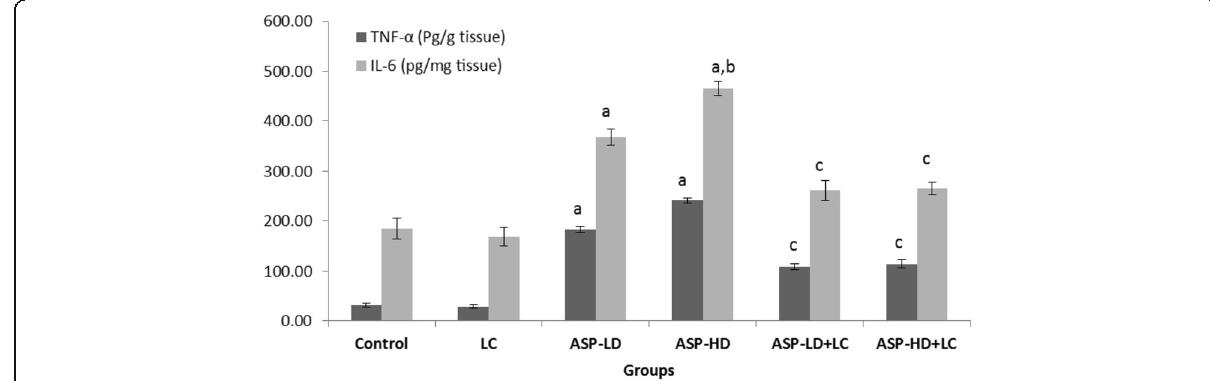
Fig. 1 Effect of L -carnitine on TNF- α and IL-6 in the brain of male rats treated with aspartame. Values are expressed as mean ± SE, n = 8. The significant value was represented at the top of the column. TNF- α , tumor necrosis factor – alpha; IL-6, interlukin-6. a Significant difference as compared to control, and b significant difference as compared to ASP-LD. c Significant difference as compared to its relative group of ASP ( P ≤